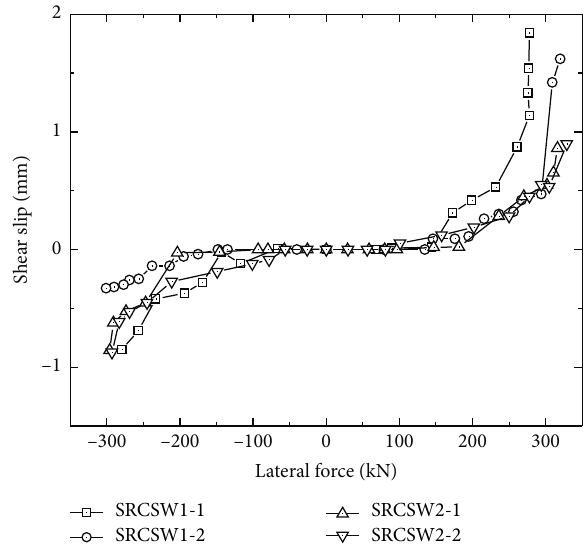
Figure 14: Shear-slip versus lateral force